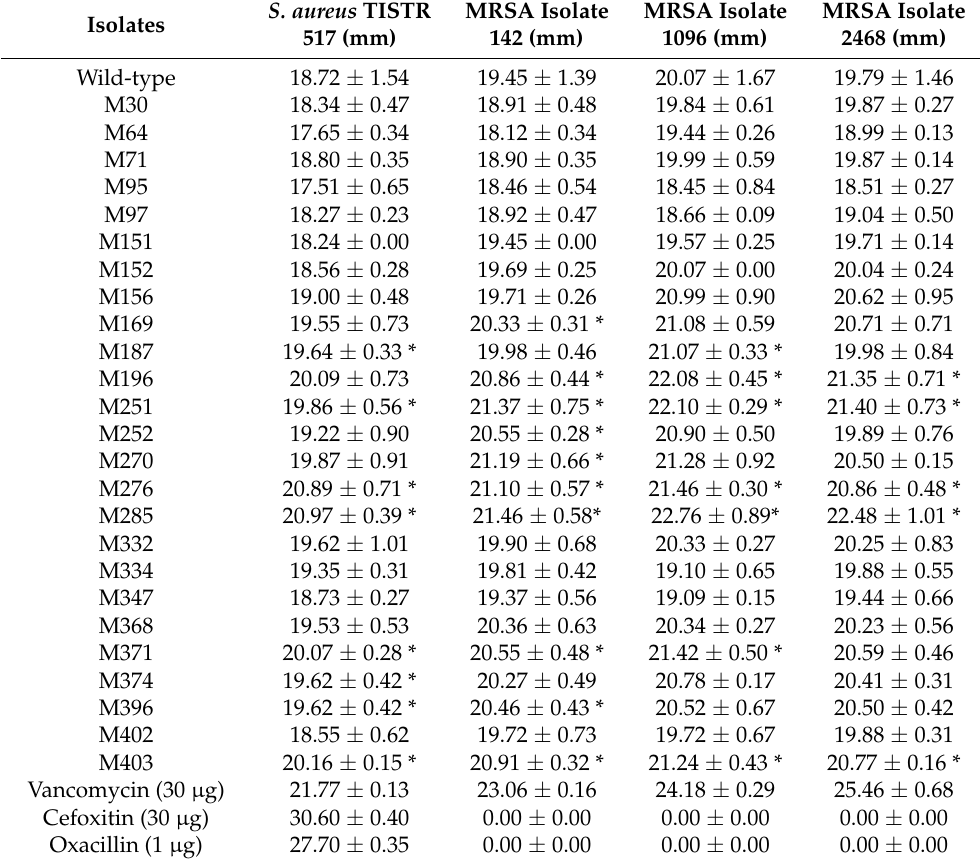
Table 1. Comparison of antibacterial activity between the wild-type and its mutants by agar well diffusion (mean ± SD; n =